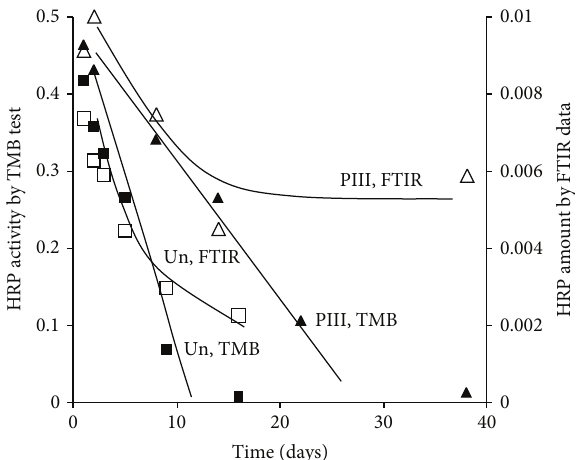
F 17: HRP activity (by TMB test data) and amount of HRP (by FTIR data) on untreated (Un) and PIII-treated (PIII) UHMWPE surface with storing time in buffer solution at room temperature aer protein